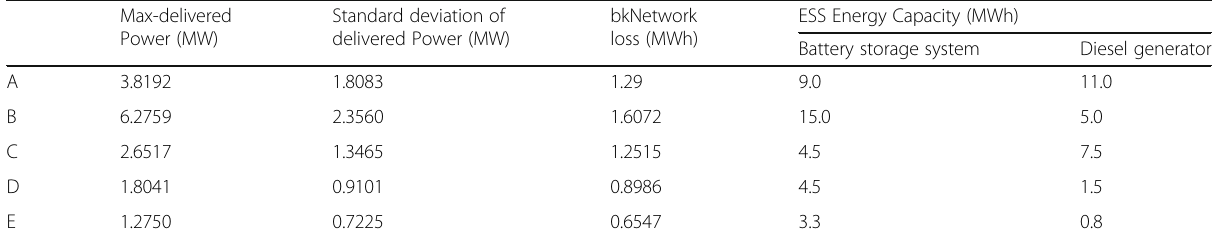
Table 4 Comparisons of results obtained in five cases Max-delivered Power